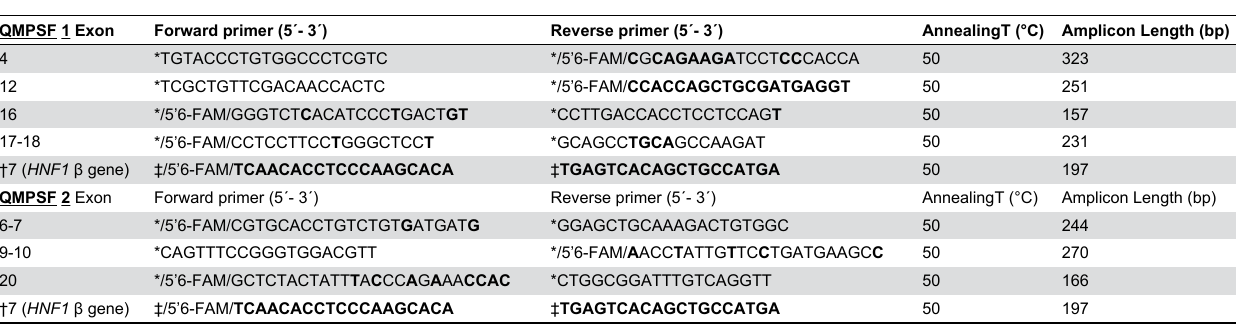
Table 3. PCR Primers for